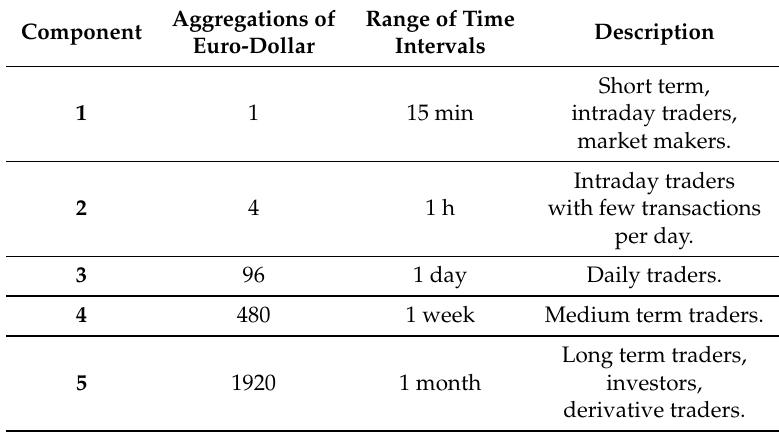
Table 1. Component description of PHARCH process for